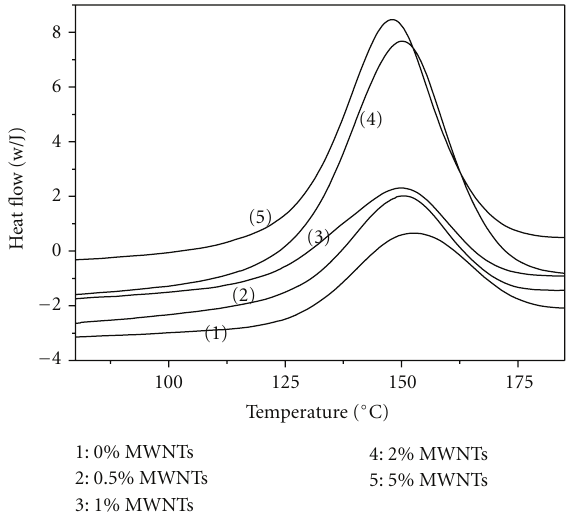
Figure 2: The influence of MWNTS OH on the thermal properties of nanocomposites.